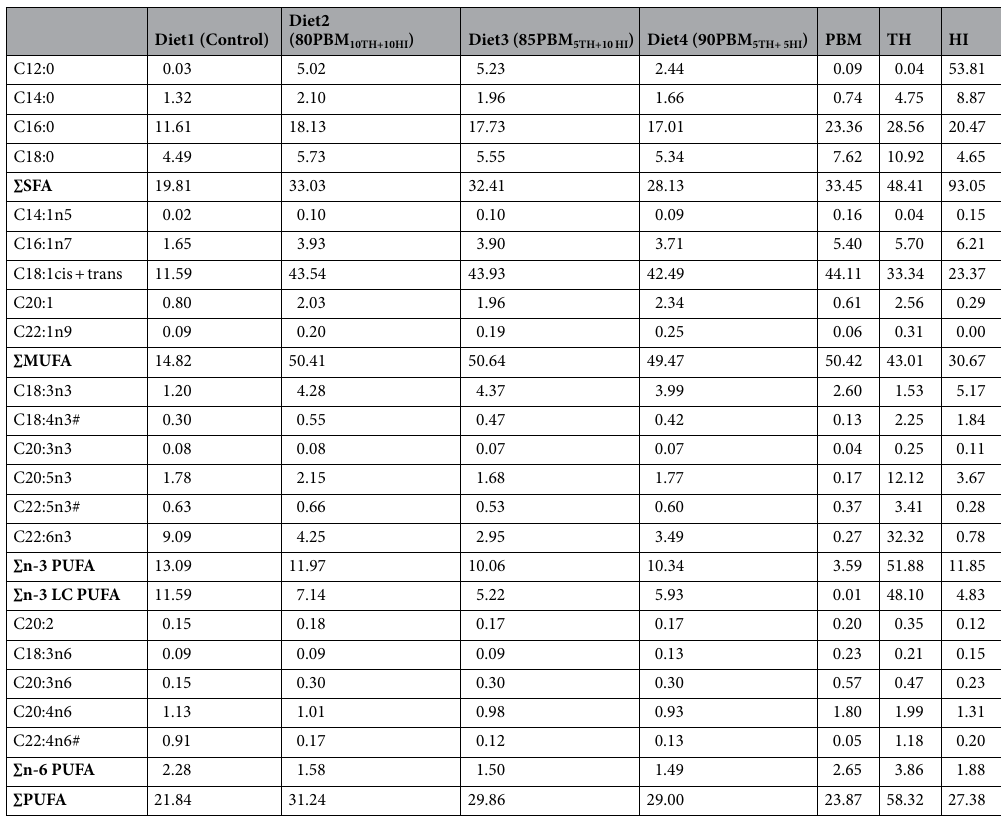
Table 3. Fatty acids composition (g/100 g DM) of PBM-based diets, combinedly supplemented with TH and HI larvae meal and different ingredients including PBM, TH and